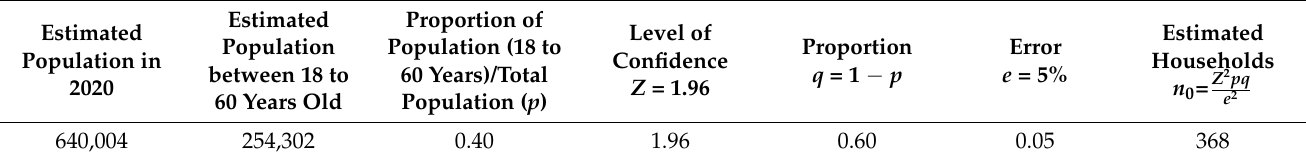
Table 1. Estimated population and representative sample of the study area.